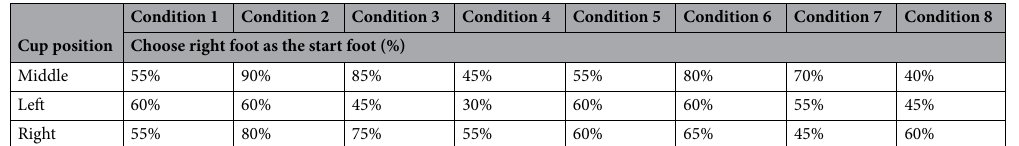
Table 4. Frequency (%) of choosing the right foot as the starting foot cross the 8 obstacle conditions. Obstacle conditions are as 1: Condition 1 (NOBST), 2: Condition 2 (AM-R80/AM-L80), 3: Condition 3 (AM-L61/R61),